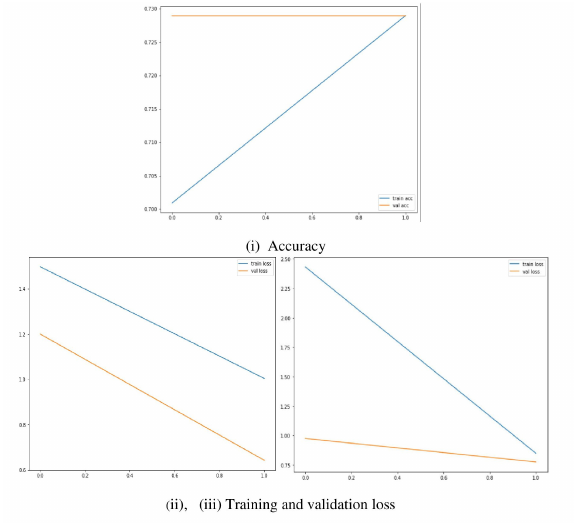
Fig. 3. (i) Accuracy of the model on the training and validation set, (ii) and (iii) Training and validation loss obtained on the given